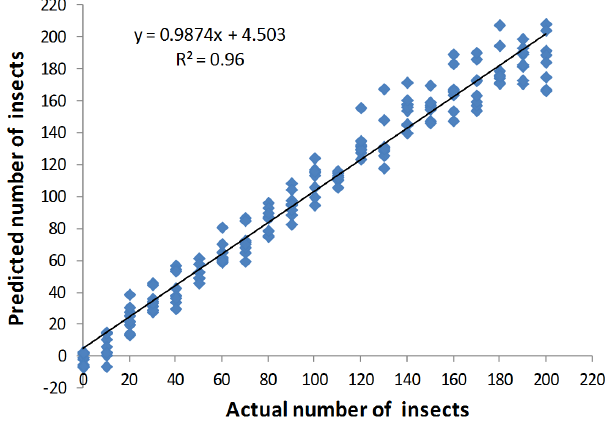
Fig. 5. Scatter plot of actual and predicted population of rice weevils in milled Hommali rice samples.